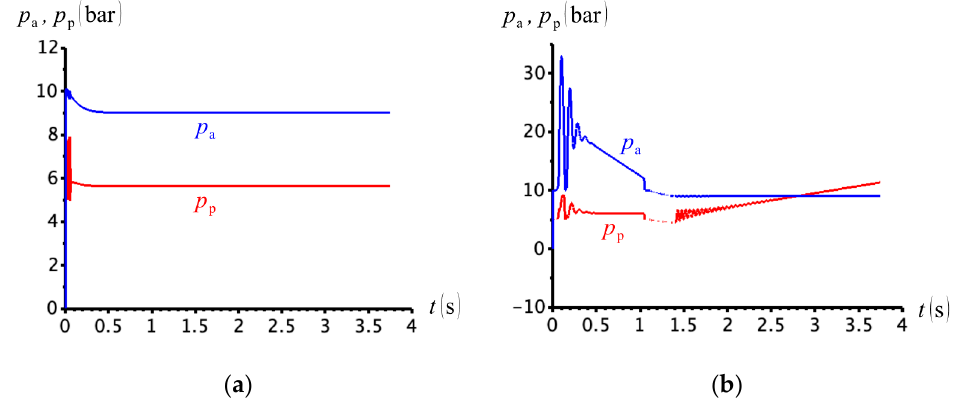
Figure 35. Cap- and rod-side pressures for ( a ) m = 0.5 kg and ( b ) m = 250 kg .